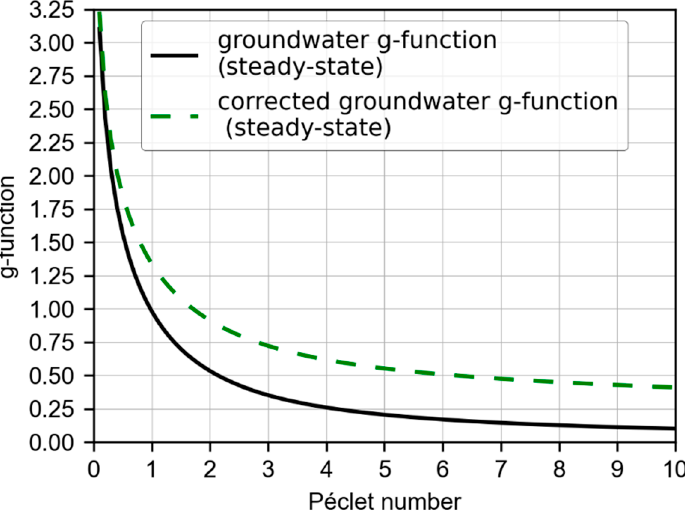
Figure 8. Groundwater g-function values for steady state conditions with and without correction.